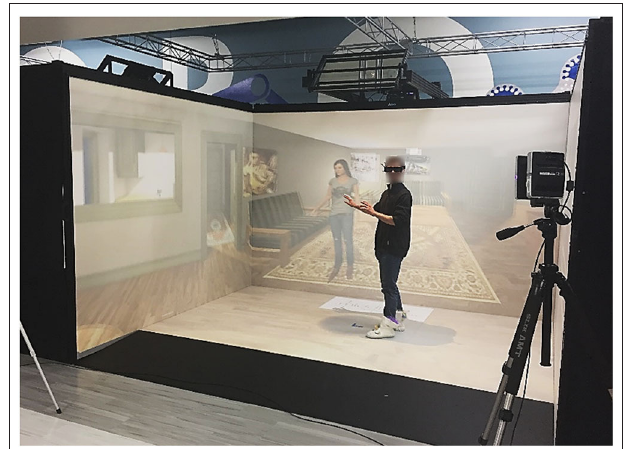
FIGURE 1 | A co-author interacting with the CAVE